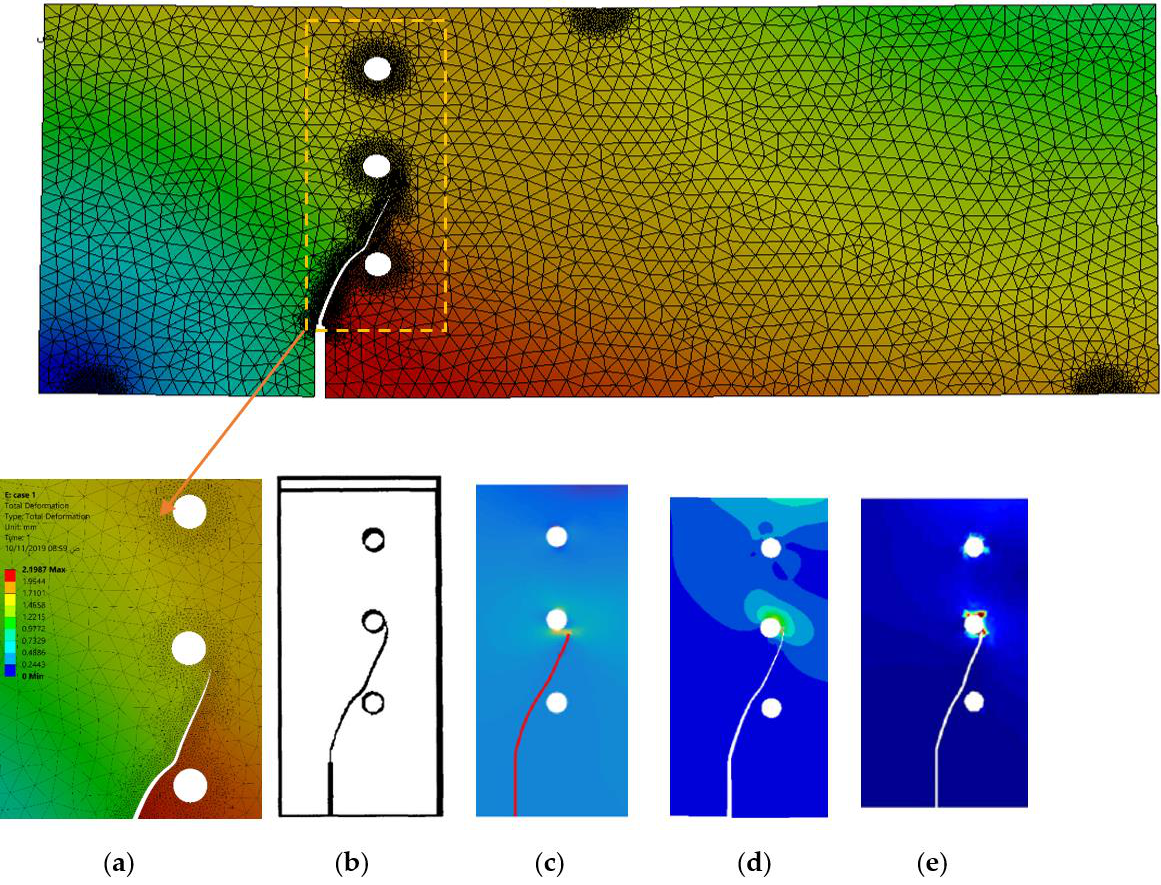
Figure 3. Specimen 1, crack growth trajectory ( a ) Ansys simulation, ( b ) experimental [45,46], ( c ) numerical results [47], ( d ) numerical results [36], ( e ) numerical results [5].